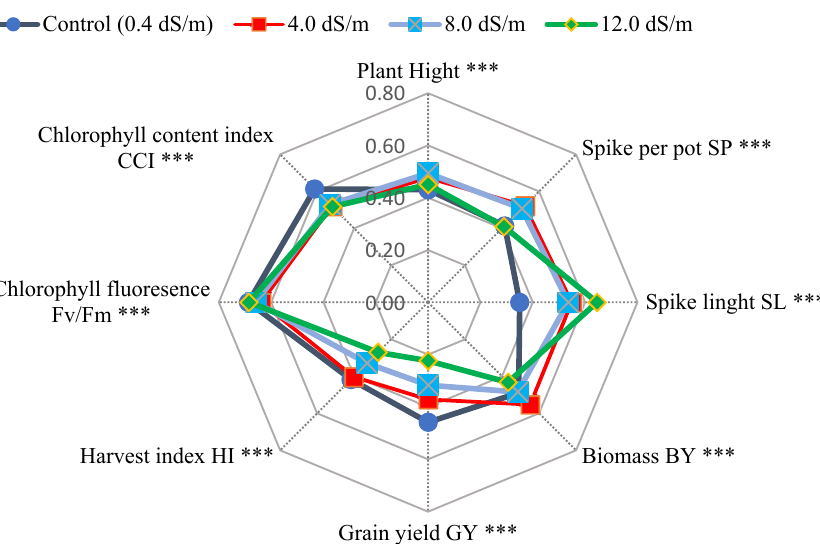
Figure 1. Radar chart for mean performance and significance of genotypes ( p < 0.001) of plant height, spikes per pot, spike length, biomass, grain yield, harvest index, chlorophyll fluorescence, and chlo- rophyll content index of forty genotypes grown under 0.4, 4.0, 8.0, and 12.0 dS/m diluted seawater in the 2019/20 season. *, ** and *** significant level at 0.05, 0.01, and 0.001, respectively. Table 4. Mean square of the analysis of variance of plant height cm (PH), spike length cm (SL), number of spikes per pot (SP), grain yield gm per pot (GY), biomass yield gm per pot (BY), harvest index % HI, chlorophyll fluorescence Fv/Fm, and chlorophyll content index CCI of forty genotypes grown under 0.4, 4.0, 8.0, and 12.0 dS/m of seawater in the 2019/20 season.